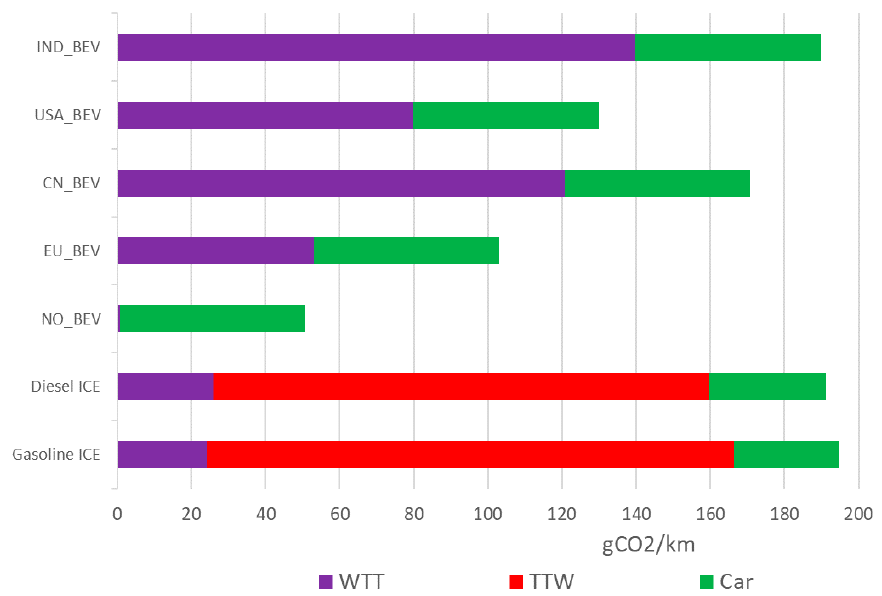
Figure 19. Total CO 2 emissions of BEVs in various countries compared to gasoline and diesel cars (based on the electricity generation mix of 2018).